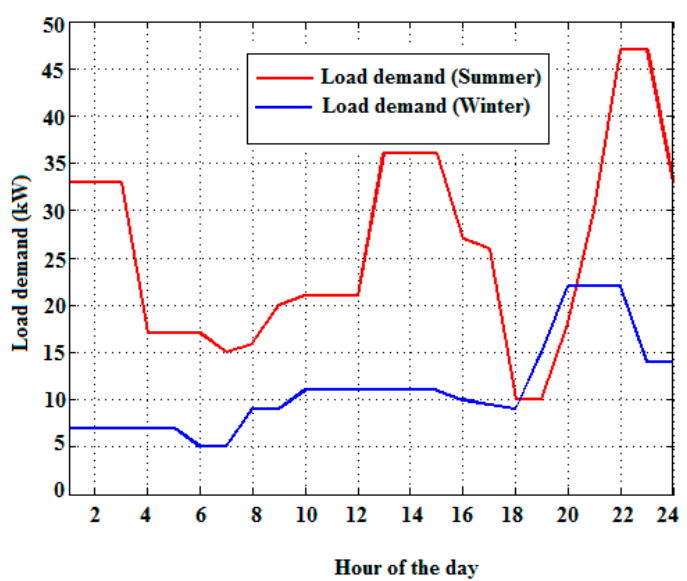
Figure 4. The load profile of summer and winter.